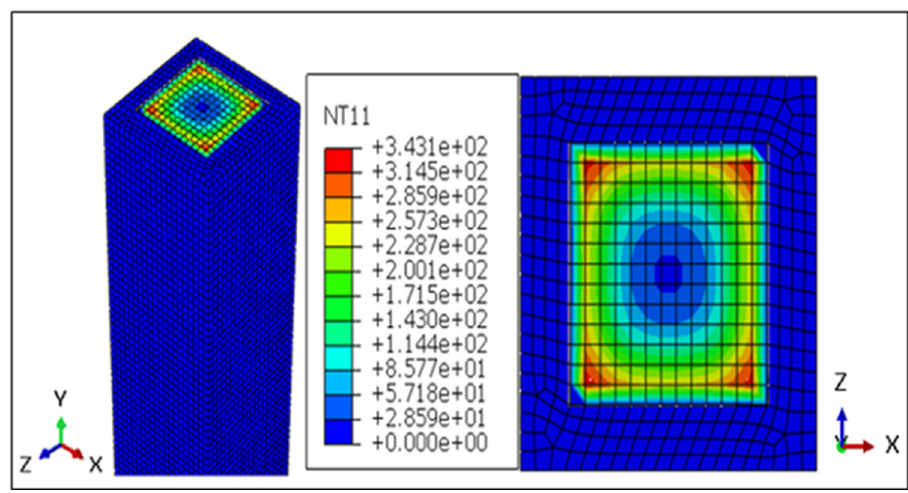
Figure 17: The temperature distribution after full time of burning for strengthened RC column.